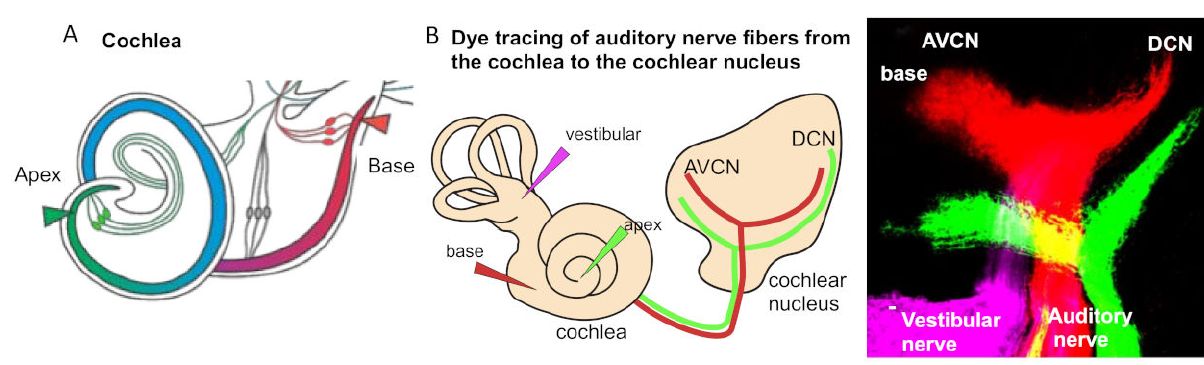
Figure 2. Tonotopic organization. ( A ) An illustration of the cochlea and its tonotopy across the frequency spectrum. High-frequency sounds maximally stimulate the base of the cochlea (red), whereas low-frequency sounds maximally stimulate the apex (green). ( B ) The tonotopic organization of the cochlear nucleus can be visualized by lipophilic dye tracing. Diagram of applications of different colored dyes (magenta, vestibular organs; red, base; and green, apex) to label distinct bundles of neuronal fibers of the auditory nerve projecting to the cochlear and vestibular nuclei. Representative image of triple-dye labeling from the cochlea shows the trajectory of low- (green from the apex) and high-frequency (red from the base) auditory nerve fibers and the tonotopic organization of the cochlear nucleus subdivisions, the anteroventral (AVCN) and dorsal cochlear nucleus (DCN), in mouse embryos at embryonic day 18.5. Image from Reference